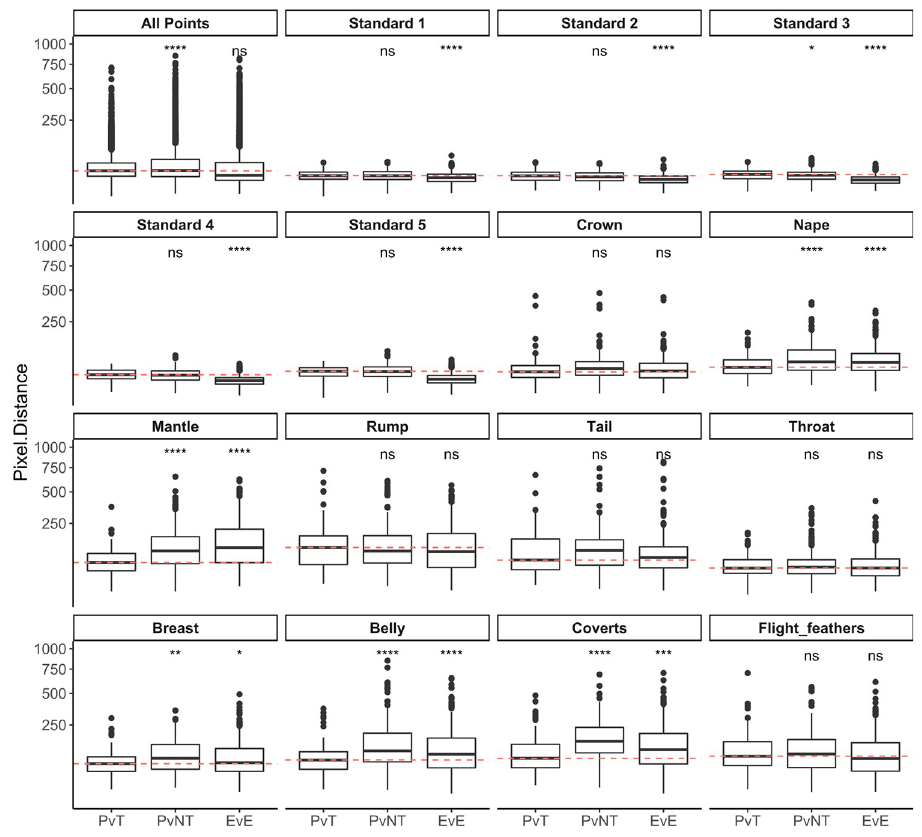
Fig 6. Pixel distances for experts and Deep Learning comparison. Pixel distances are compared across three groups: predictions vs expert trainer (PvT); predictions vs expert non-trainer (PvNT); between experts (EvE). Red dotted lines are the median of PvT. Significant symbols are t-test that compares PvT against PvNT or EvE (ns: p > 0.05; � : p < = 0.05; �� : p < = 0.01; ��� : p < = 0.001; ���� : p < = 0.0001). All Y axes (pixel distance) are square root scaled.